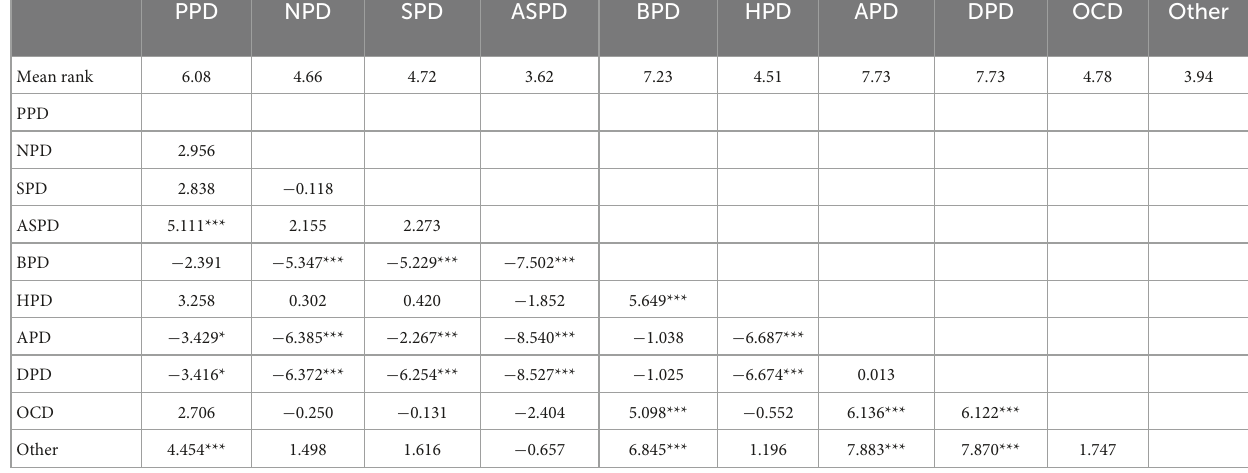
TABLE 3 Female clinicians’ likelihood of diagnosis in cases with vulnerable narcissism symptomatology.